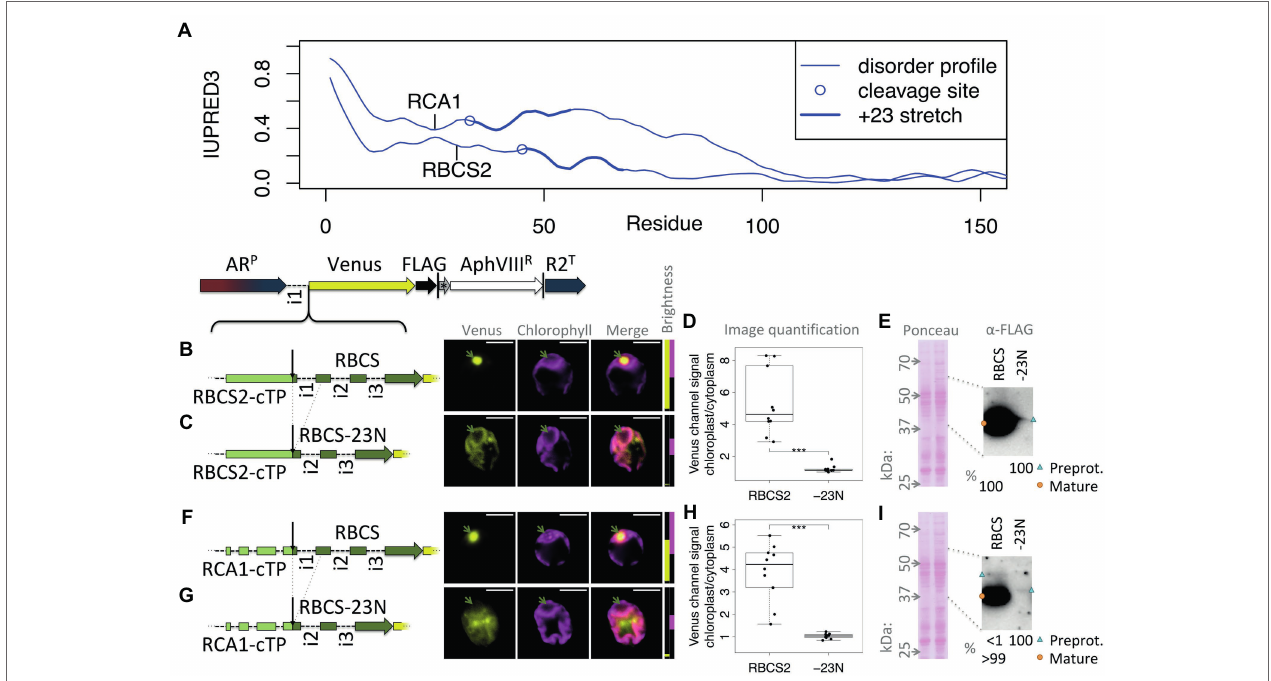
FIGURE 5 | Deleting mature protein N-termini disrupts chloroplast import and reporter accumulation. (A) IUPRED3 disorder profiles are shown for RCA1 and RBCS2 preprotein sequences as in Figure 4B , with the +23 stretch highlighted. (B) RBCS2, equipped with the native RBCS2-cTP, was introduced upstream of Venus and transformants imaged as in Figure 1 . (C) A “-23 N” construct was generated and imaged as before where the sequence encoding the N-terminal 23 residues of RBCS2 was deleted, which includes intron 1. (D) Epifluorescence images were quantified by measuring mean Venus channel signal inside and outside the chloroplast (*** signifies p < 0.001; t -test). (E) Immunoblot and corresponding Ponceau-red stained membrane are shown comparing full-length RBCS2 and the truncated -23 N construct, both driven by RBCS2-cTP. (F) full-length and (G) truncated (-23 N) versions of RBCS2 where fused to the RCA1-cTP, and analyzed by microscopy, epifluorescence quantification (H) , and (I) immunoblot as before. Green arrows highlight the pyrenoid, blue triangles preprotein bands, and orange circles mature protein